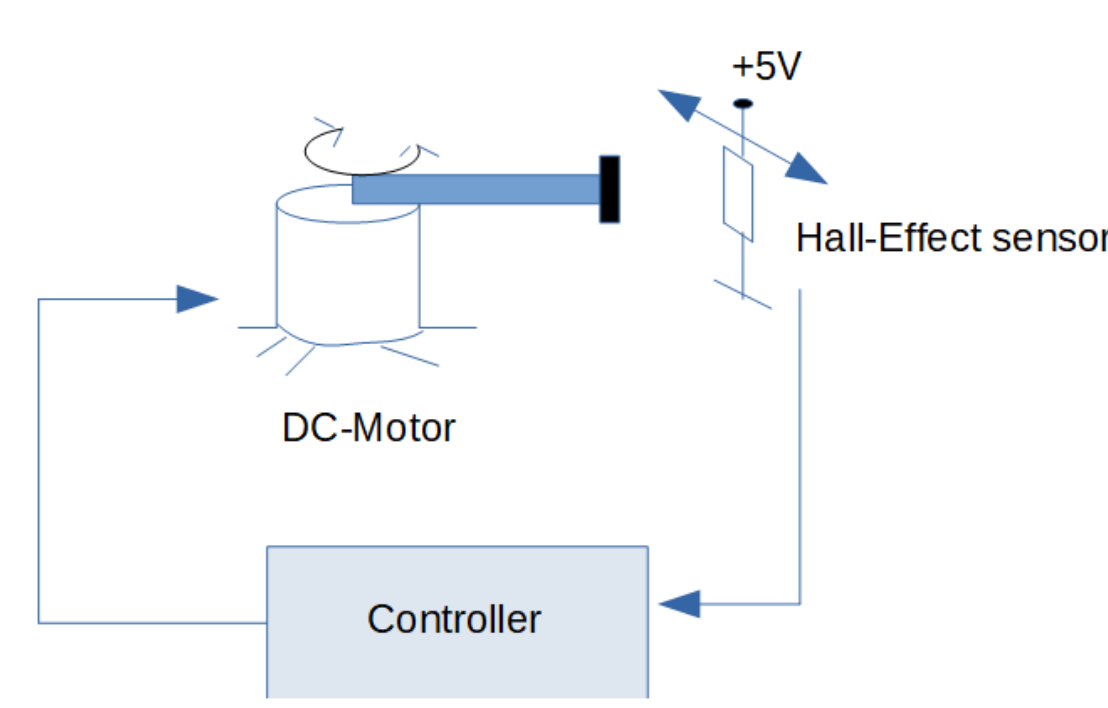
Figure 1. A schematic representation of a DC-Motor under control. The magnet, represented in the black drawing, follows the moveable Hall-effect